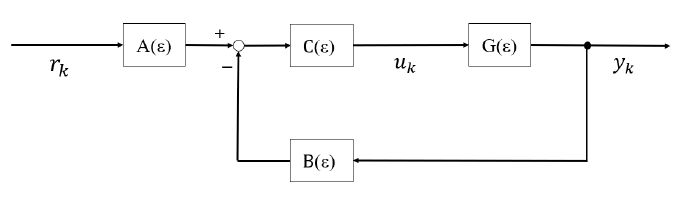
Figure 5. Structure of controller design by the PIM